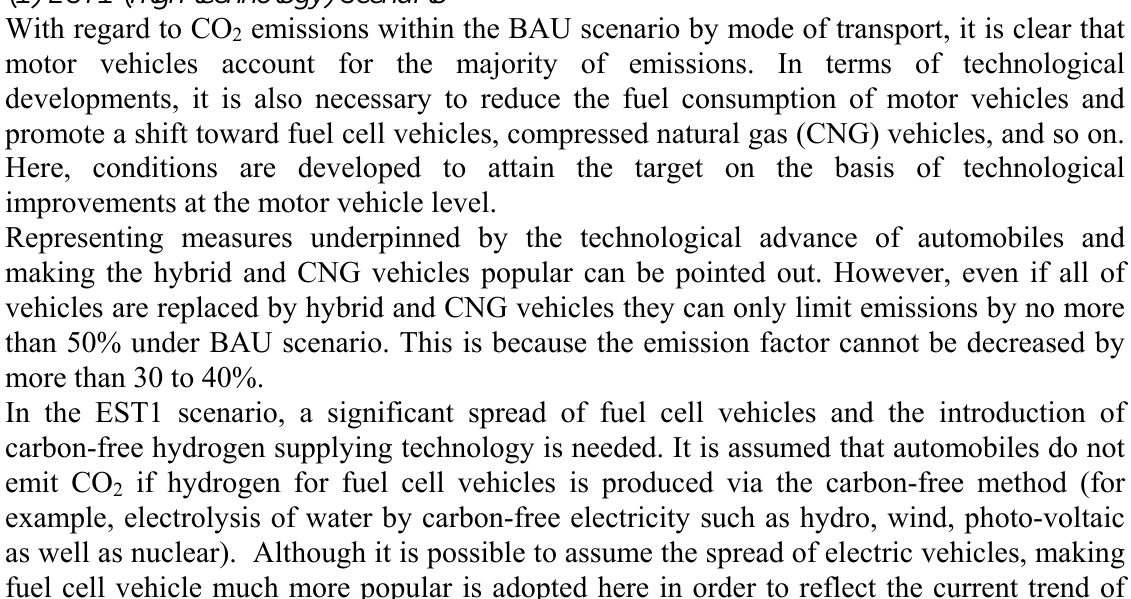
emissions in 1990 and under the BAU scenario in 2030 (Japan on a national 2